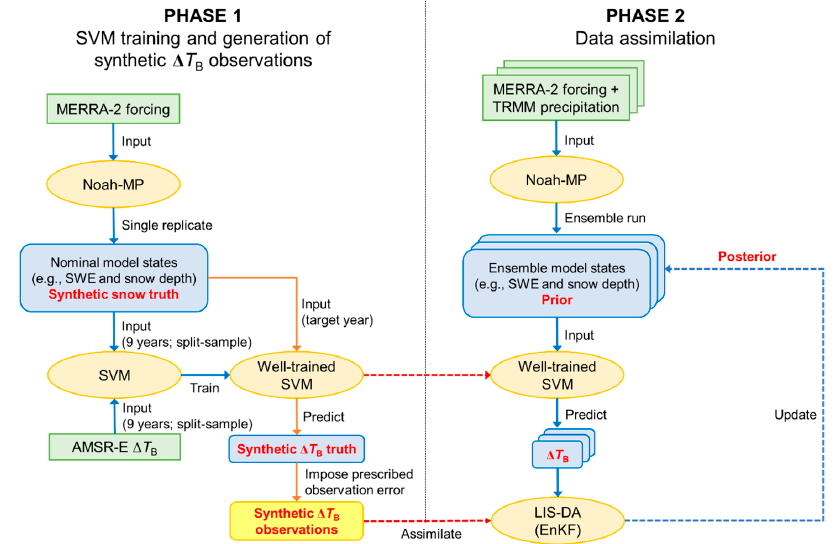
Figure 1. Schematic diagram for the synthetic twin experiment using the Land Information System (LIS) and a well-trained support vector machine (SVM) as the observation operator.